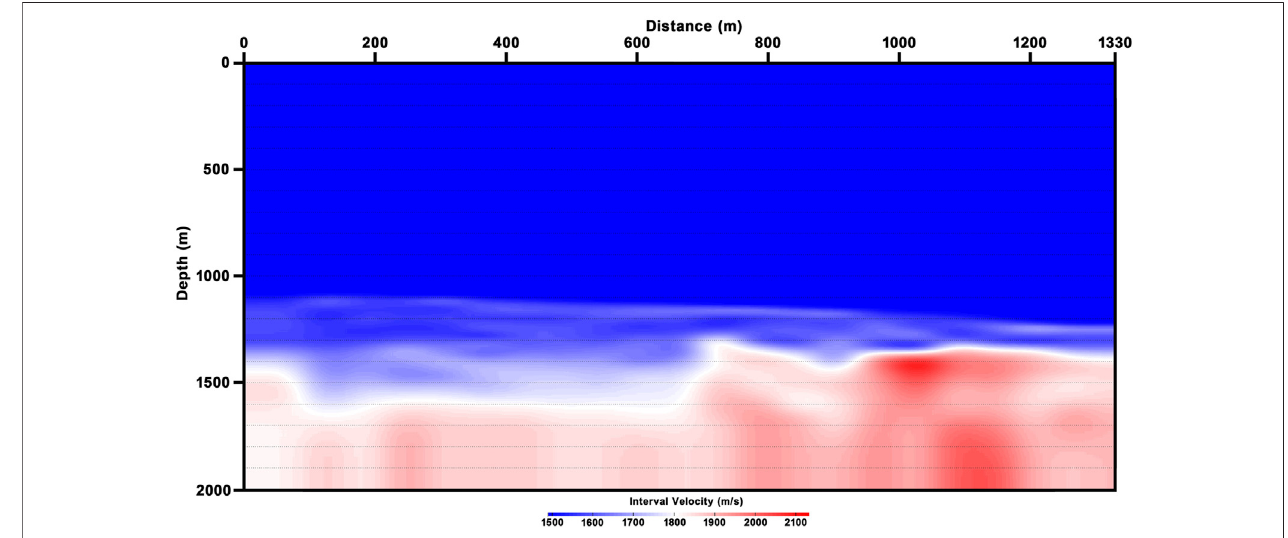
FIGURE 8 | Velocity model used for